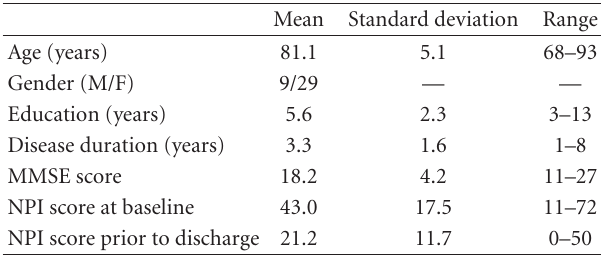
Table 1: Demographics of the subjects ( n = 38).